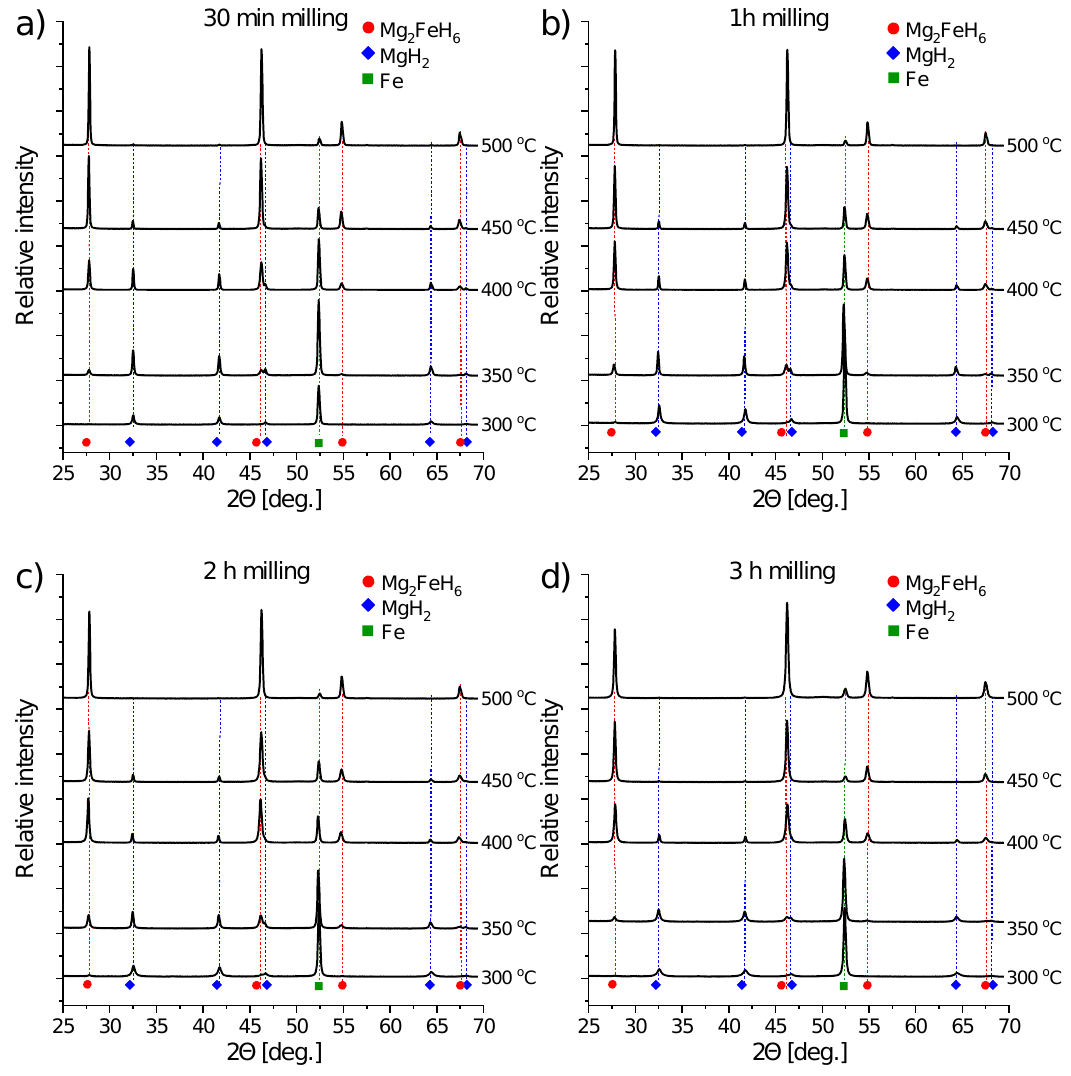
Figure 3. Diffraction patterns of samples after milling the MgH 2 + Fe mixture for ( a ) 30 min, ( b ) 1 h, ( c ) 2 h and ( d ) 3 h followed by sintering at different temperatures under hydrogen